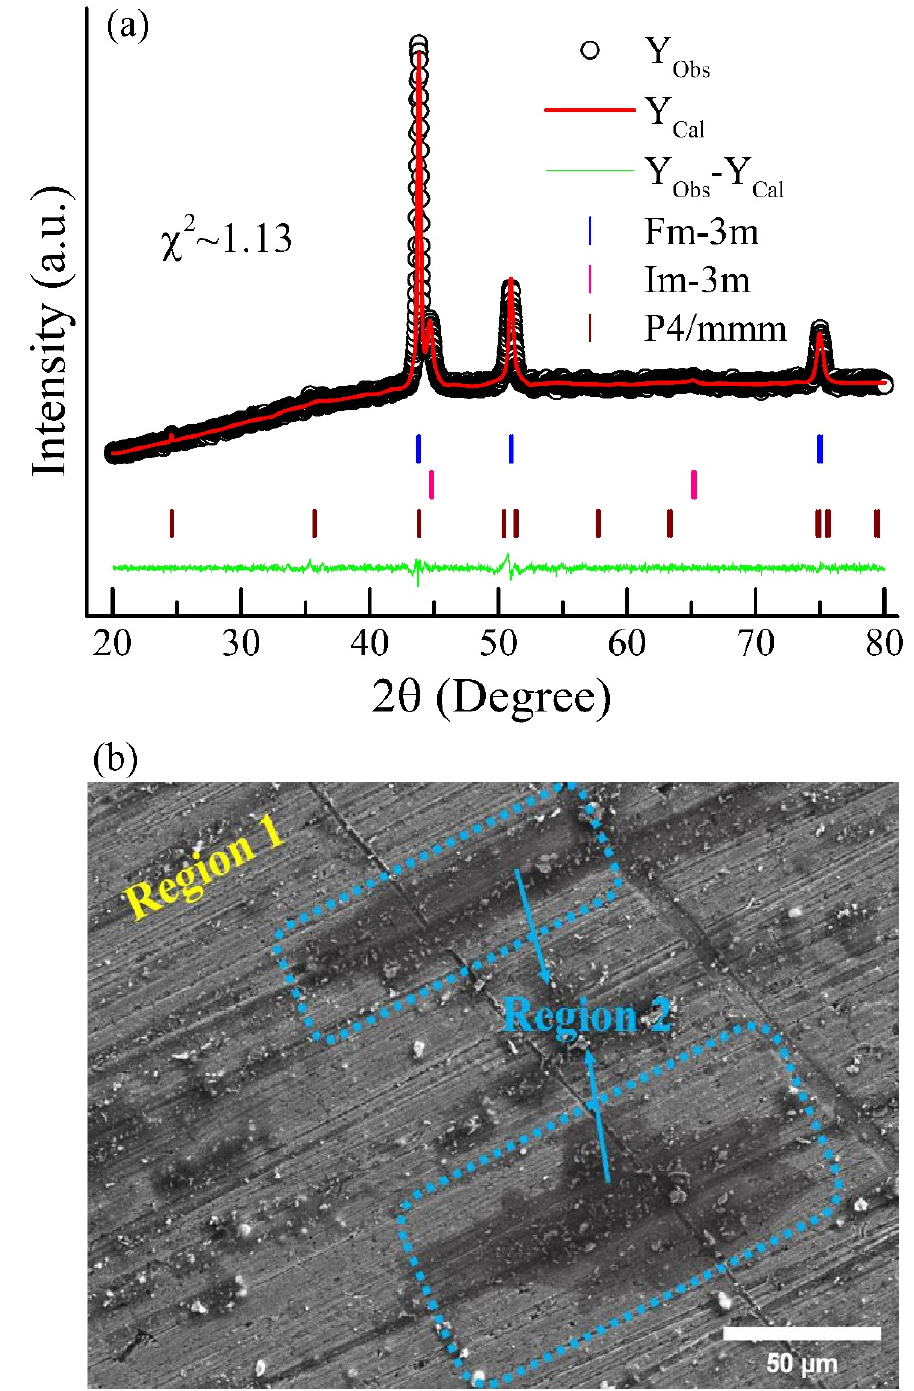
Figure 1. Structural and microstructure of studied compounds: ( a ) Rietveld analysis of X-ray diffraction pattern for the Fe 65 Ni 35 alloy. Bragg position of phase 1 (blue color) for the Fm-3m phase; Bragg position of phase 2 (Pink color) for the Im-3m phase; Bragg position of phase 3 (Wine color) for the P4/mmm phase. ( b ) SEM micrograph for the studied alloys.